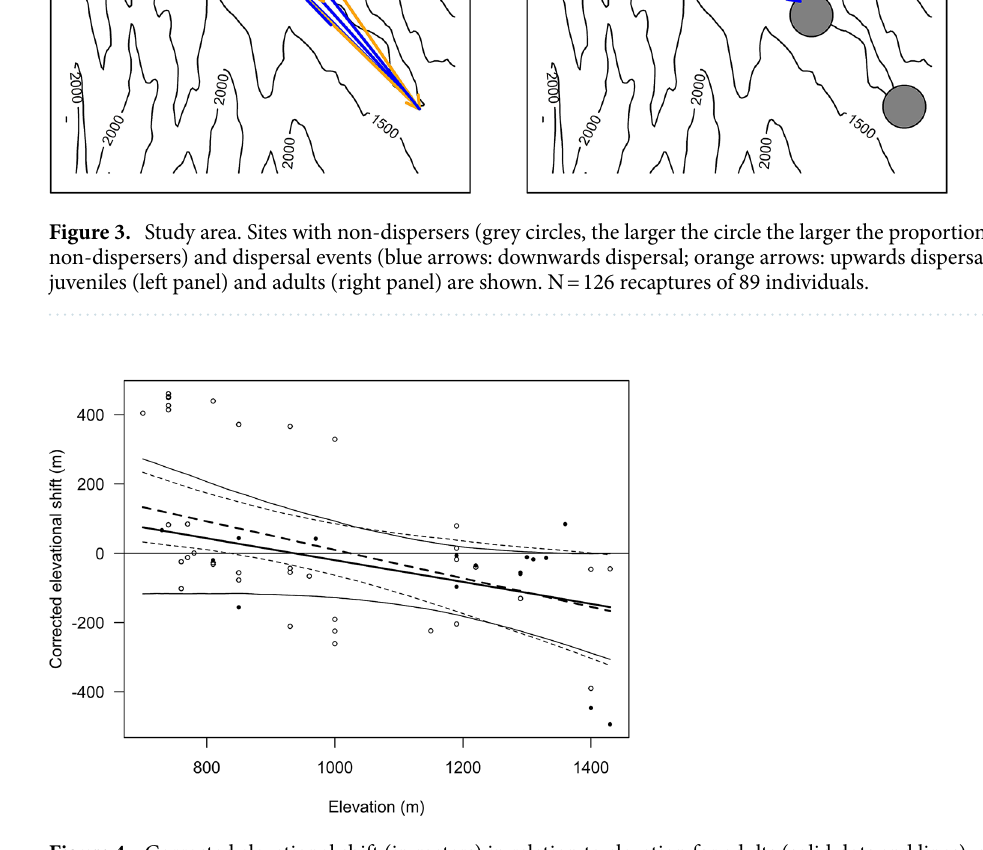
Figure 4. Corrected elevational shift (in meters) in relation to elevation for adults (solid dots and lines), and juveniles (open circles and broken lines). The 95% credible intervals are indicated by the outer lines. N = 56 dispersal events of 51 individuals from 26